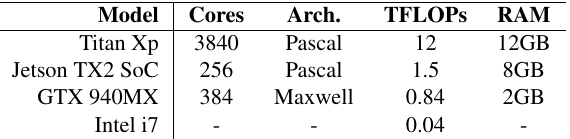
Table 2. Hardware comparison.